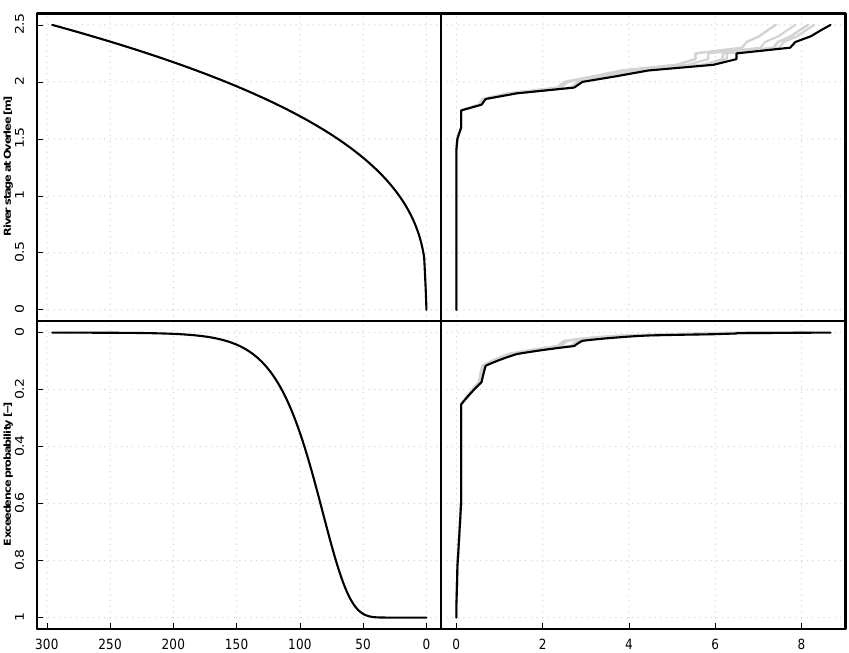
Fig. 4. Hydro-economic EAD model for the No Warning (black) and Perfect Forecasts (grey) cases. Reduced damage as a result of flood warning response results in reduced expected damage; from right to left panels, grey lines show damage curves as a function of increasing mitigation times from 1 to 6h. Resulting flood risk is listed in Table 2.